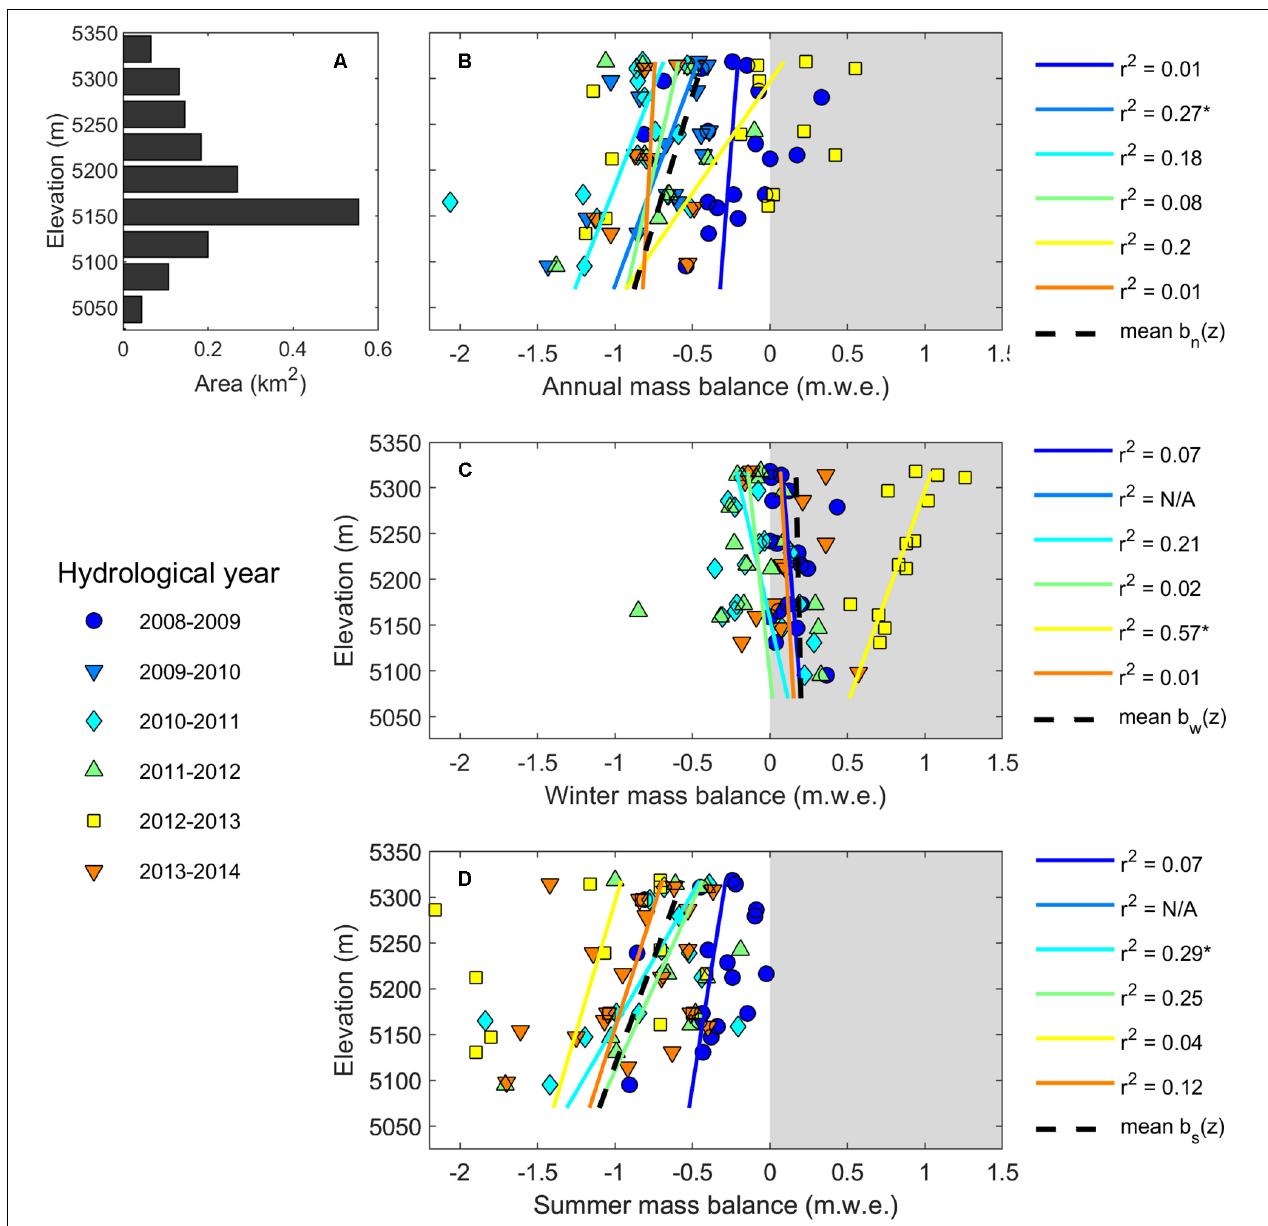
FIGURE 3 | Guanaco Glacier mass balance gradients. (A) Hypsometry; Mass balance – elevation relationships for (B) annual mass balance; (C) winter mass balance; (D) summer mass balance. The variance explained by each linear regression model ( r 2 ) is shown in legend. Significant regression models are marked with an asterisk ( p < 0.05). N/A: missing seasonal balance